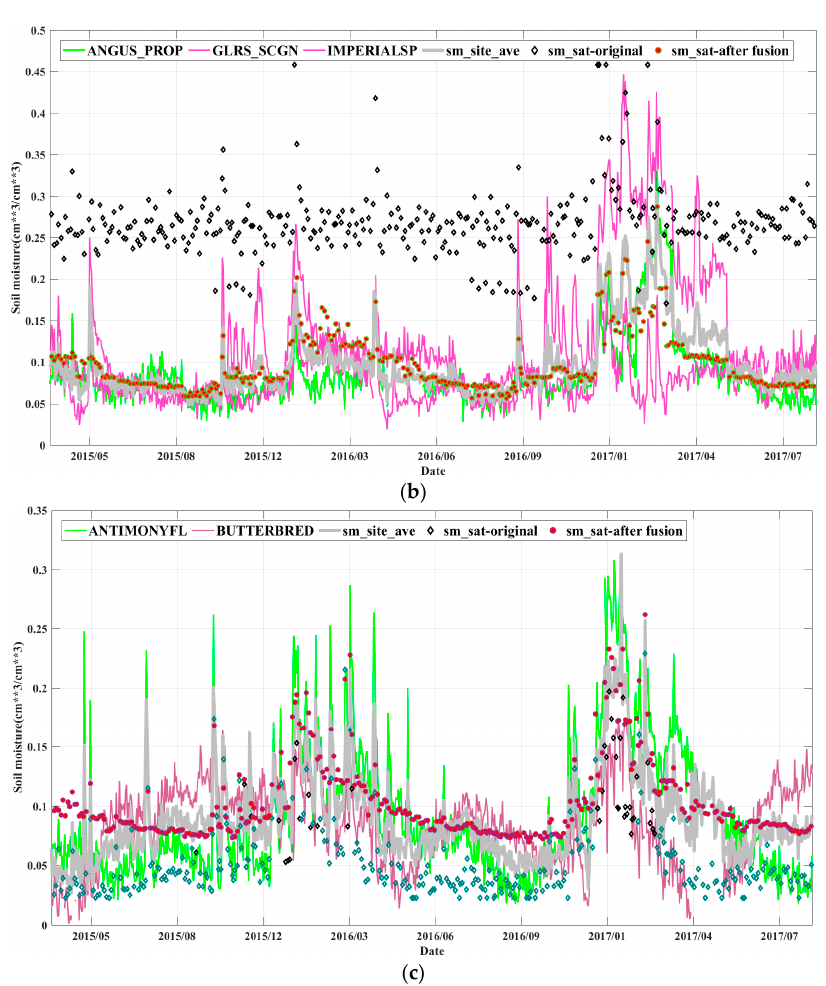
Figure 6. Site-specific SSM time series compared with the coincident SMAP SSM time series before and after fusion for three examples of 36-km EASEv2 pixels, which include ( a ) one site (Tucson_11_W), ( b ) three sites (ANGUS_PROP, GLRS_SCGN, IMPERIALSP), and ( c ) two sites (ANTIMONYFL, BUTTERBRED), respectively. The central latitude and longitude of each pixel are ( a ) (32.2881°N, 111.0996°W), ( b ) (33.2921°N, 115.5809°W), and ( c ) (35.3352°N, 118.1950°W), respectively. Note that